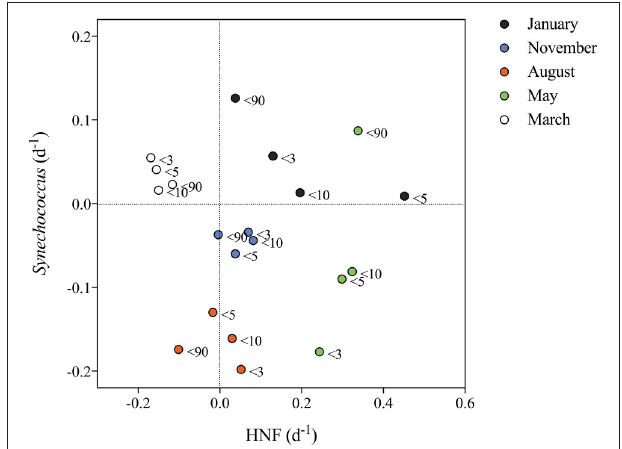
FIGURE 6 | Net growth rates (d − 1 ) of Synechococcus plotted against HNF net-growth. Net growth rates are obtained from the fractionation experiments from each cruise where an exponential growth curve was fitted to the change in abundance of the respective cells during a 5-day period ( Figure S1 ). The color indicates the month and the legend at each point indicates the size-fraction treatment from which the values were obtained.